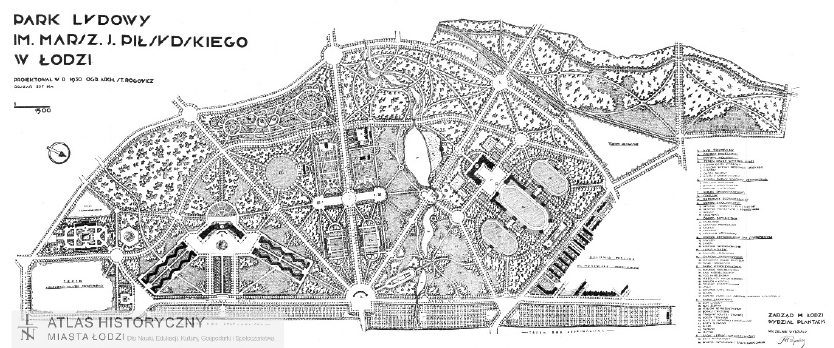
Figure 19. Design for Józef Pi ł sudski park called Park na Zdrowiu from 1930. Source: